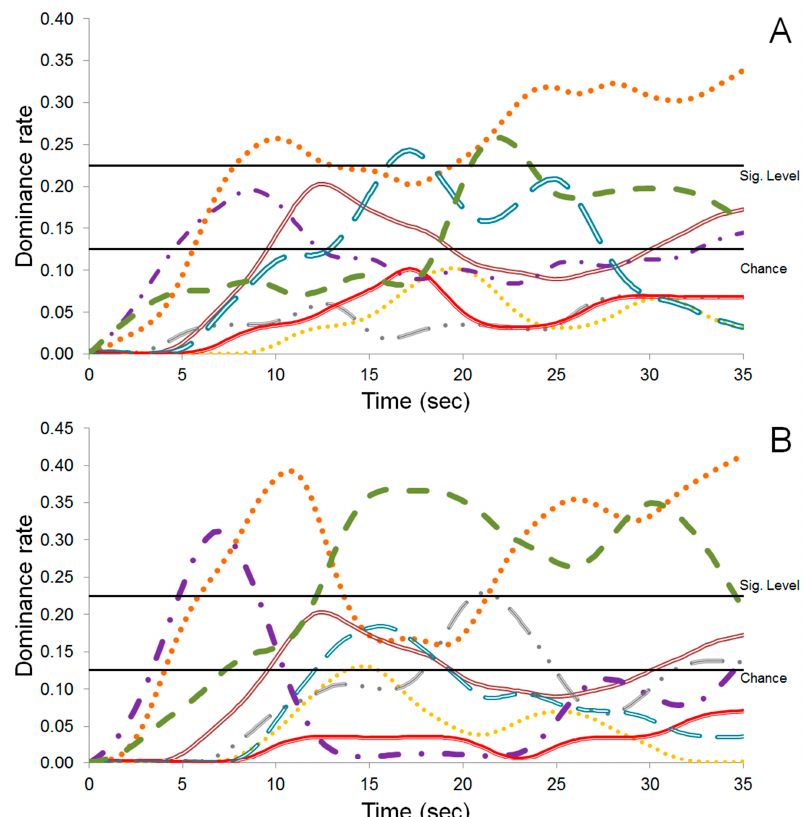
Figure 5. Temporal Dominance Sensory of chocolate produced from cocoa fermented beans PH15 NI ( A ) and PH15 I ( B ). Sensorial attributes: Acid ( ).